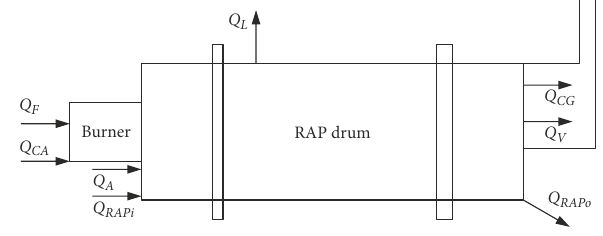
Figure 3. Heat balance model in the RAP parallel